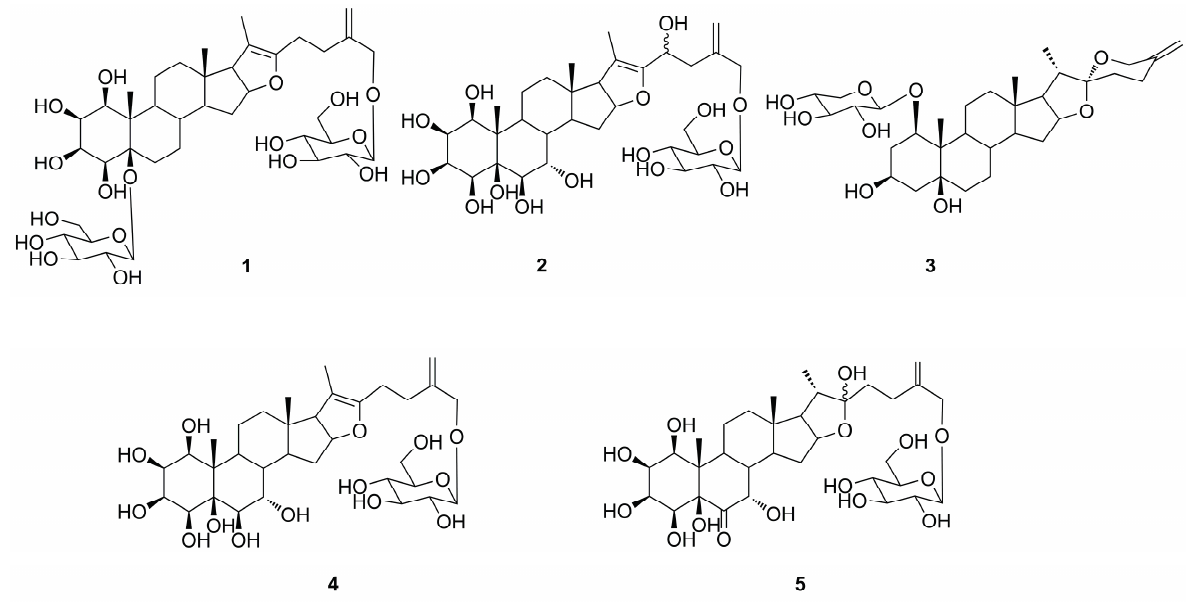
Figure 1. Structures of compounds 1 – 5